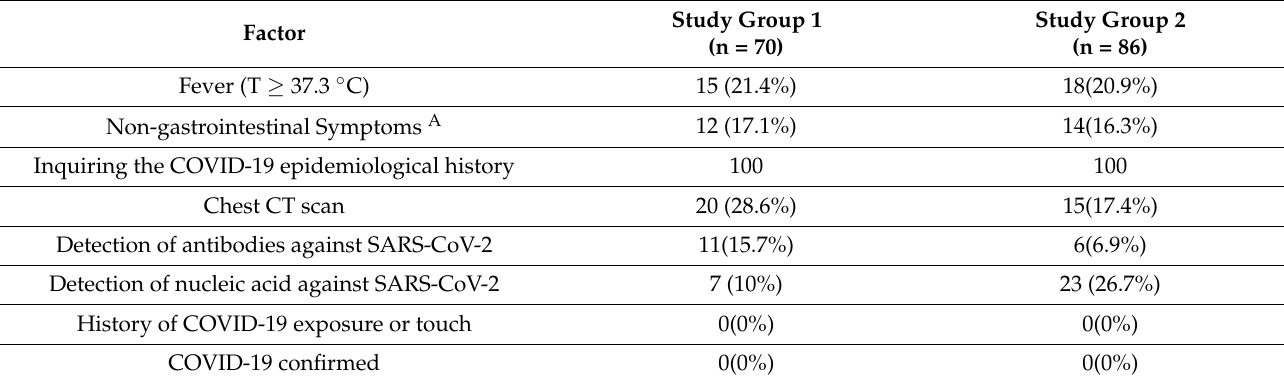
Table 3. Related screening measures of COVID-19 for pediatric patients with